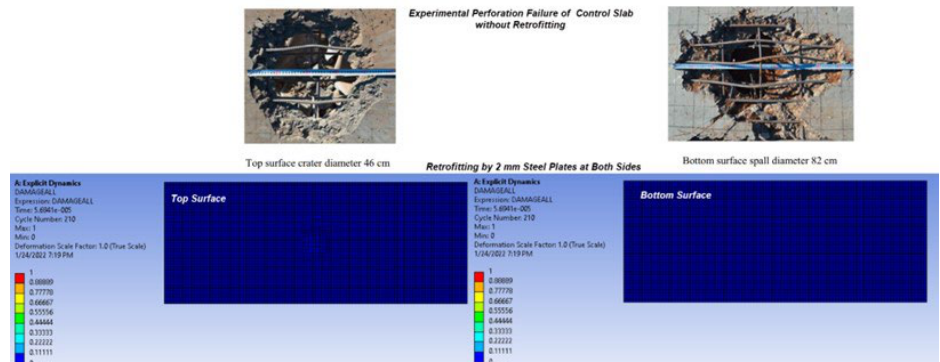
Figure 16– Comparison between mode of failure of experimental non-retrofitted NRC-2 Slab and retrofitted NRC-2 by 2 mm steel skin plates at top & bottom